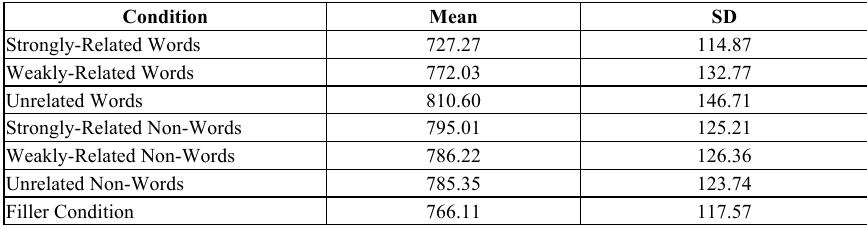
Table 2. Summary of Mean Reaction Time and Standard Deviations (in milliseconds) for Condition in the Lexical Decision Task – Experiment 2: Sounds Like Word (N = 111)